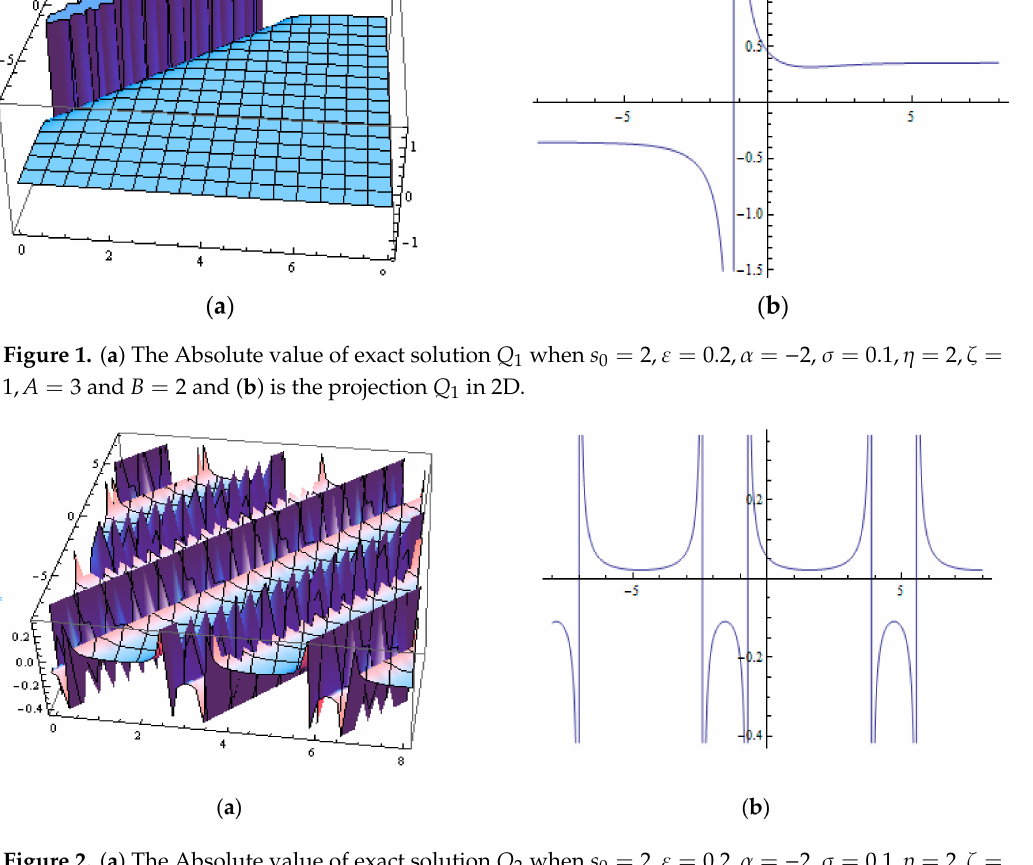
Figure 2. ( a ) The Absolute value of exact solution Q 2 when s 0 = 2, ε = 0.2, α = − 2, σ = 0.1, η = 2, ζ = 1, A = 3 and B = 2 and ( b ) is the projection Q 2 in